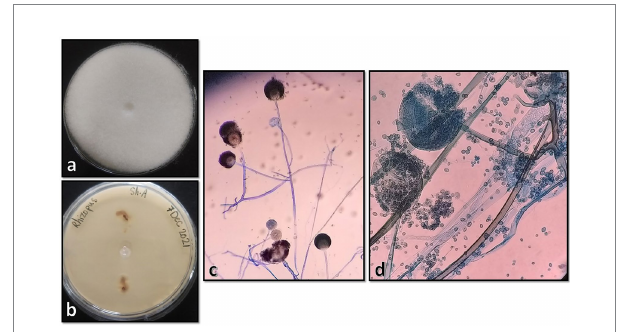
FIGURE 3 Surface and reverse of the isolated Rhizopus oryzae colony on Sabouraud dextrose agar after 4 days of incubation at 25 ° C (A,B) , and its microscopic morphology by ×100 and ×400 magnifications, respectively (C,D) .